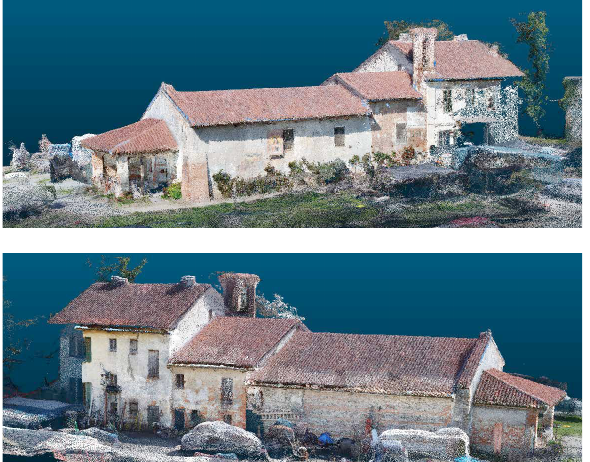
Figure 10 Two view of the achieved dense point cloud of the San Giuliano